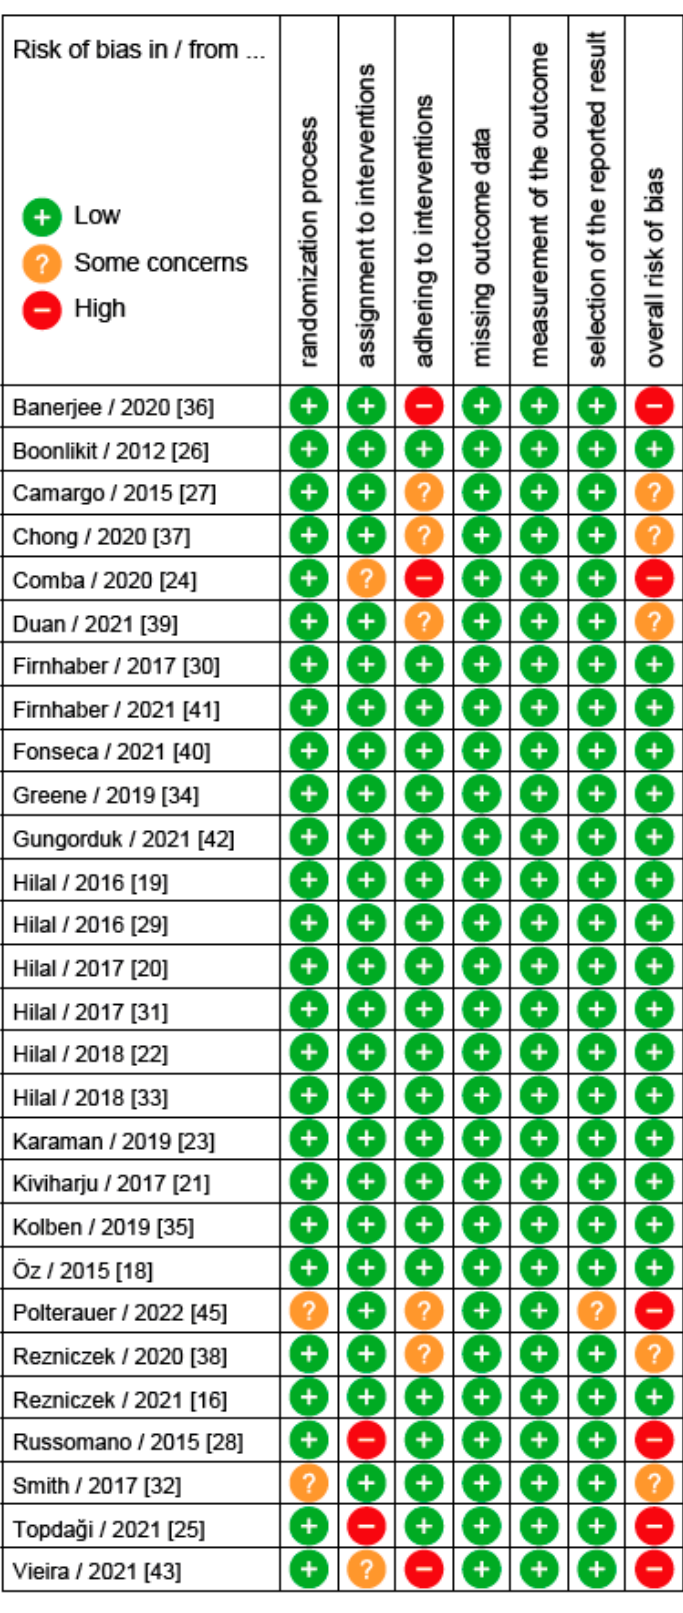
Figure 2. Methodological quality summary (according to the Cochrane Risk of Bias 2 tool [11]): Re- view authors’ judgements about each methodological quality item for each included study reporting on a randomized controlled trial ( n = 28).